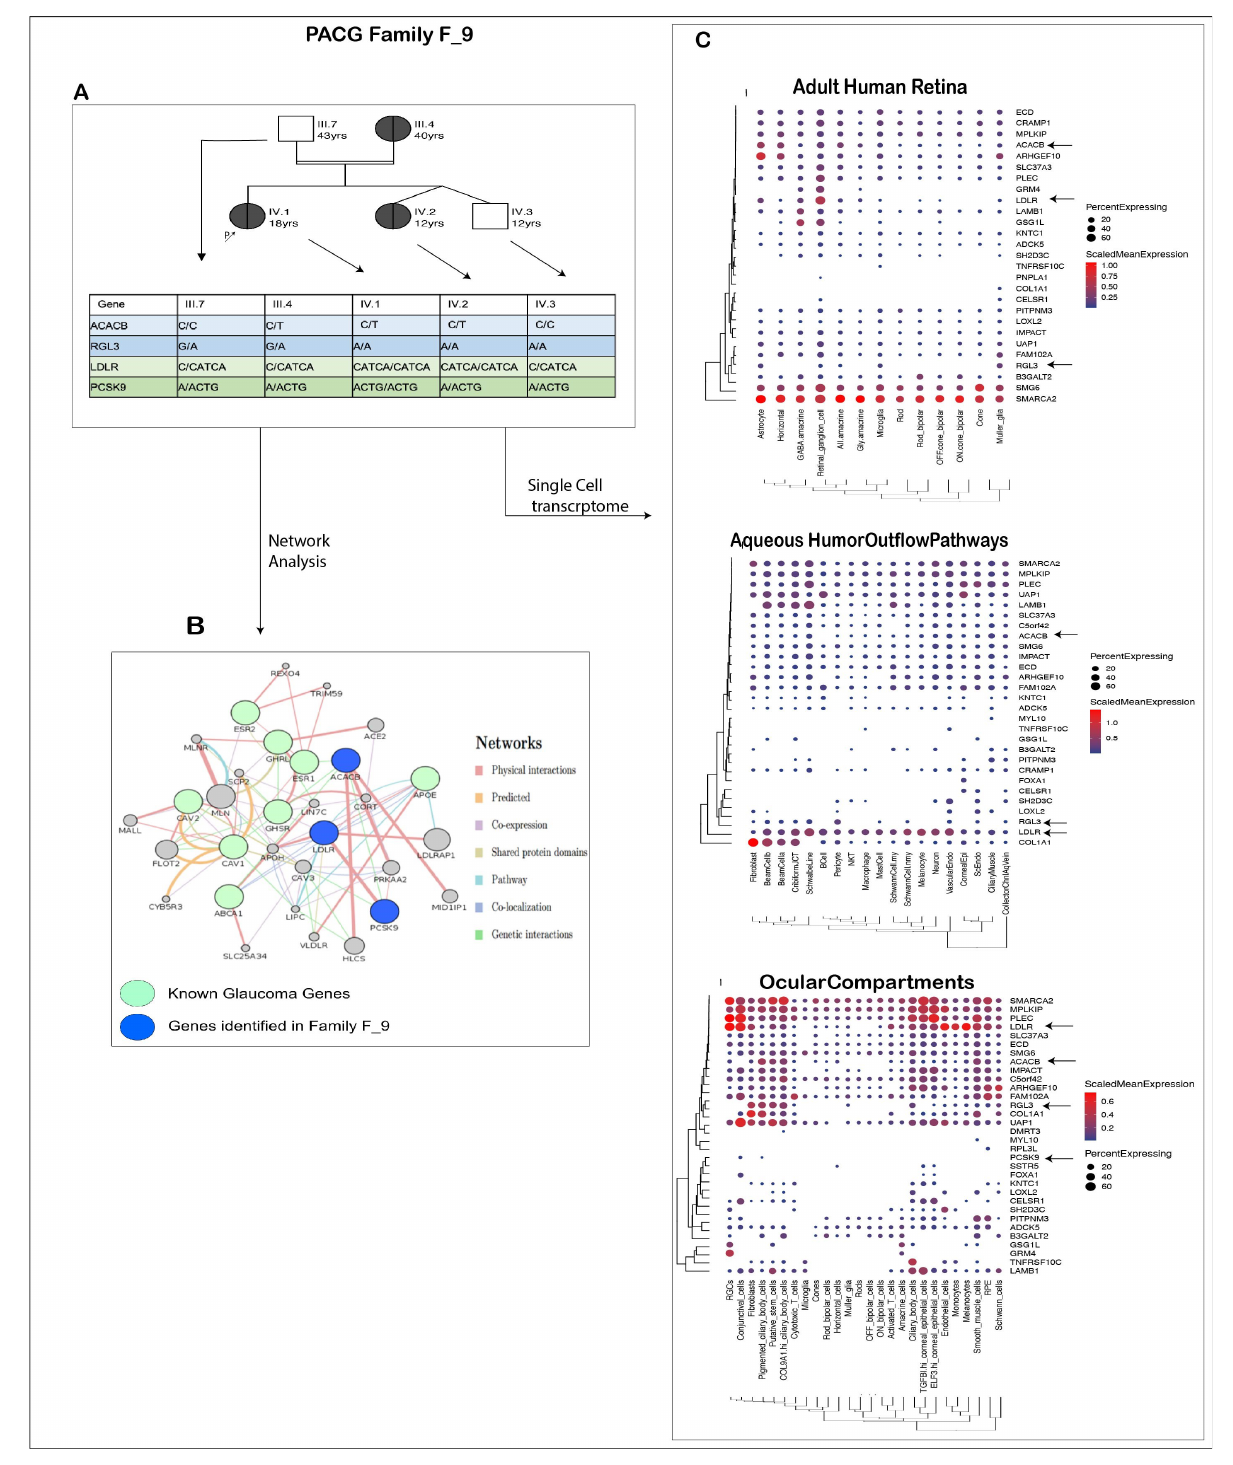
Figure 6. Detailed analysis of PACG family. ( A ) Figure showing pedigree of the members of F_9 PACG family and the probable genotypes identified from our study that may be associated with the disease. ( B ) Interaction of the known glaucoma genes that are associated with lipid metabolism (green circles) with the candidate genes ACACB, LDLR and PCSK9 identified in family F_9 (blue circles). Indirect interactions are also observed via other genes (gray) involved in the lipid metabolism and cholesterol pathways. The edges represent the type of interaction in the network, as is represented in the right panel. ( C ) Single-cell expression analysis of candidate genes in F9 family. The black arrows represent the above-discussed candidate genes in the